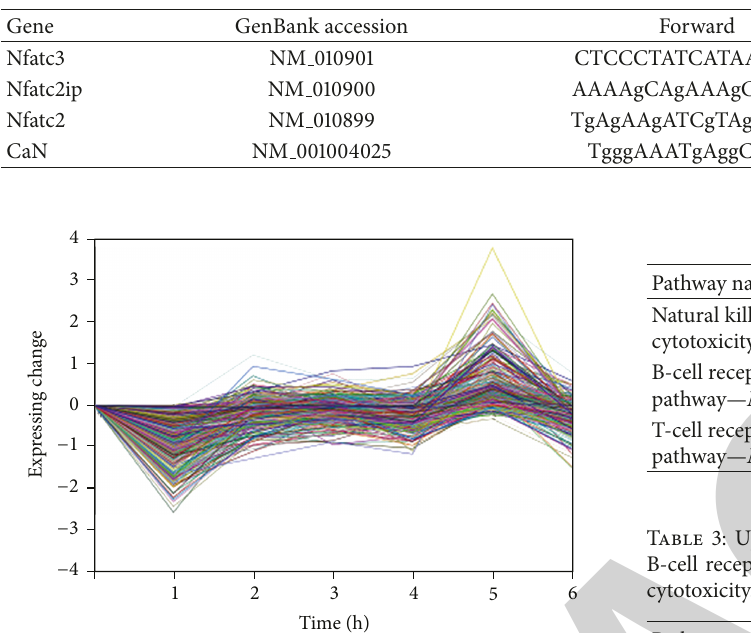
Table 1: Primers used for RT-qPCR validation and additional expression profiling.